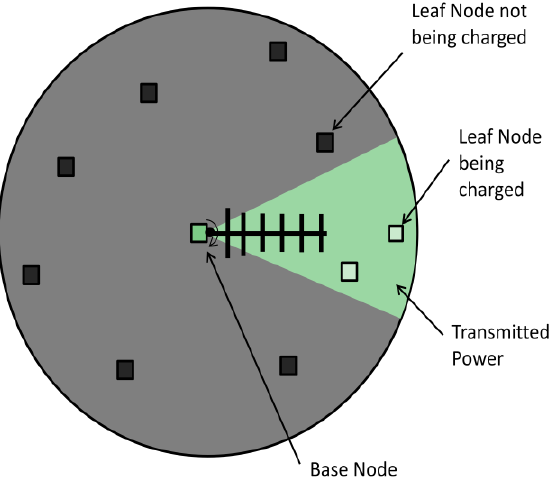
Figure 1. The RF transfer system